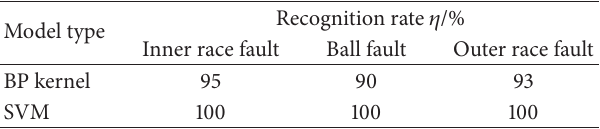
Table 1: The recognition rate of traditional RBF SVM and the